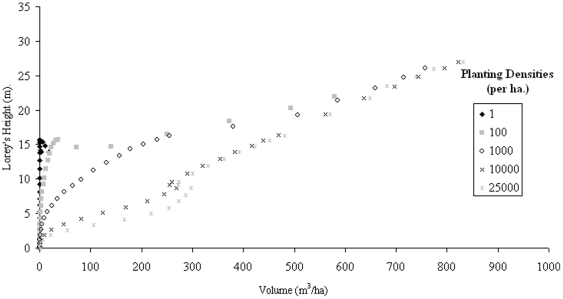

Abies Alba HLorey against stand volume over a period of 100 years.